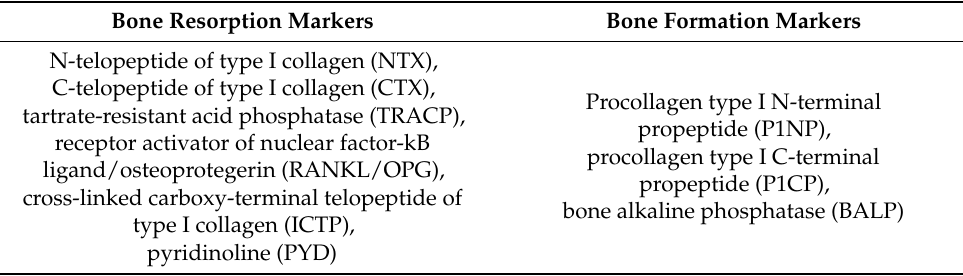
Table 1. Bone resorption and bone formation